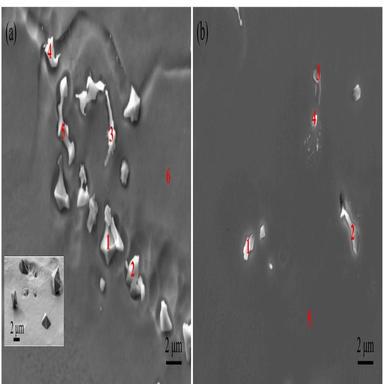
SEM image of the particles within the WM where EDX analysis was performed.